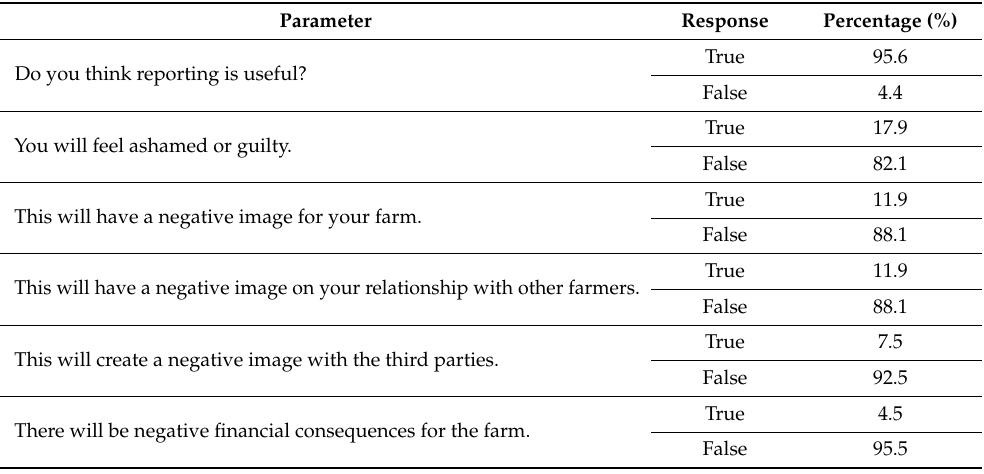
Table 10. Farmer’s attitude about reporting even if reporting turns out to be false. Parameter Response